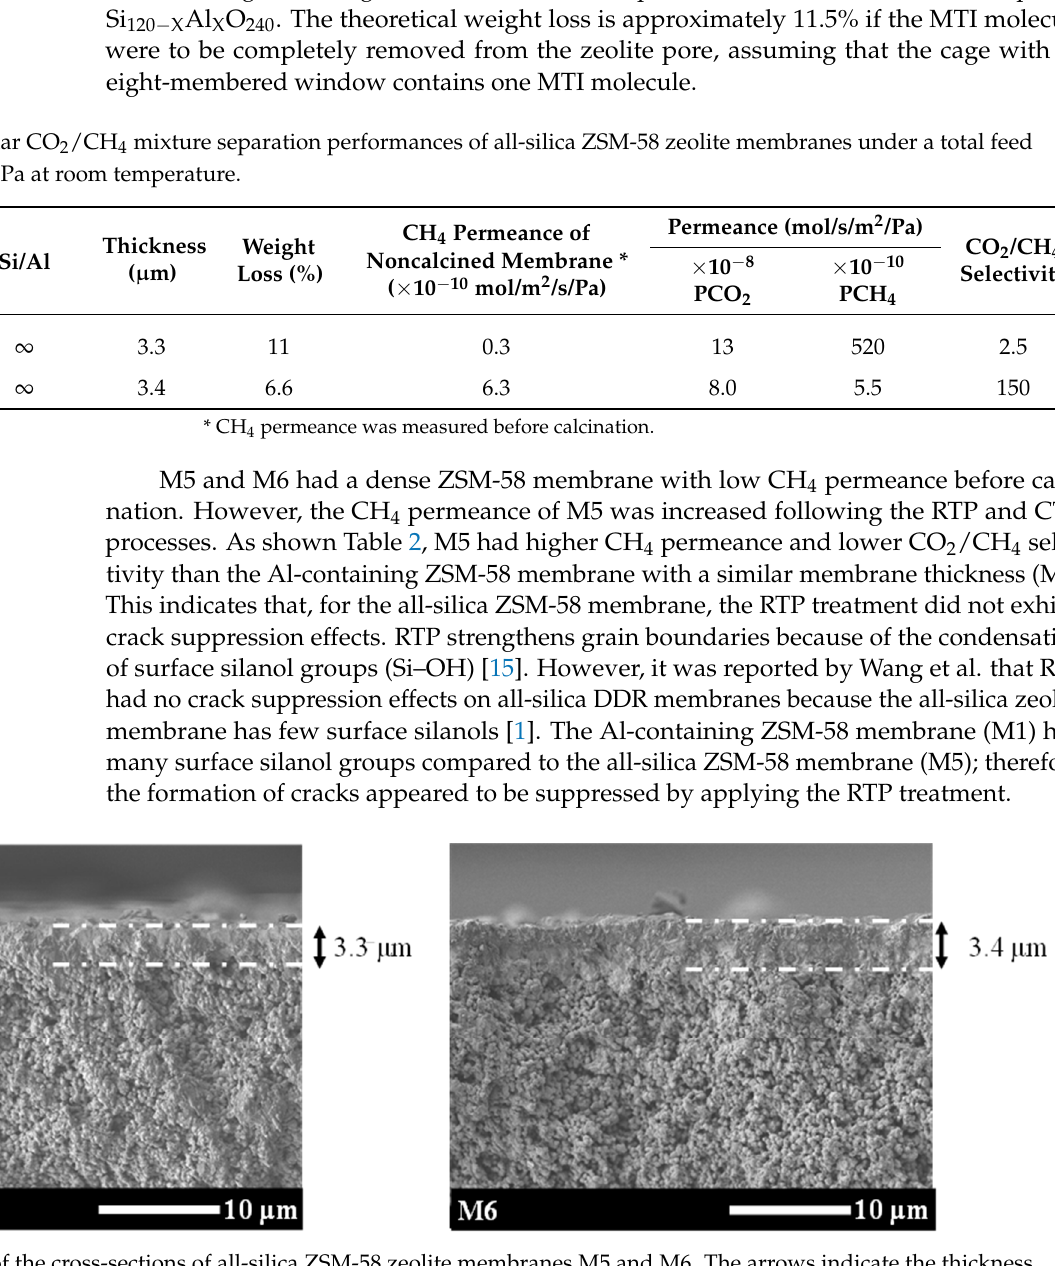
Figure 10. SEM of the cross-sections of all-silica ZSM-58 zeolite membranes M5 and M6. The arrows indicate the thickness of the zeolite membrane.